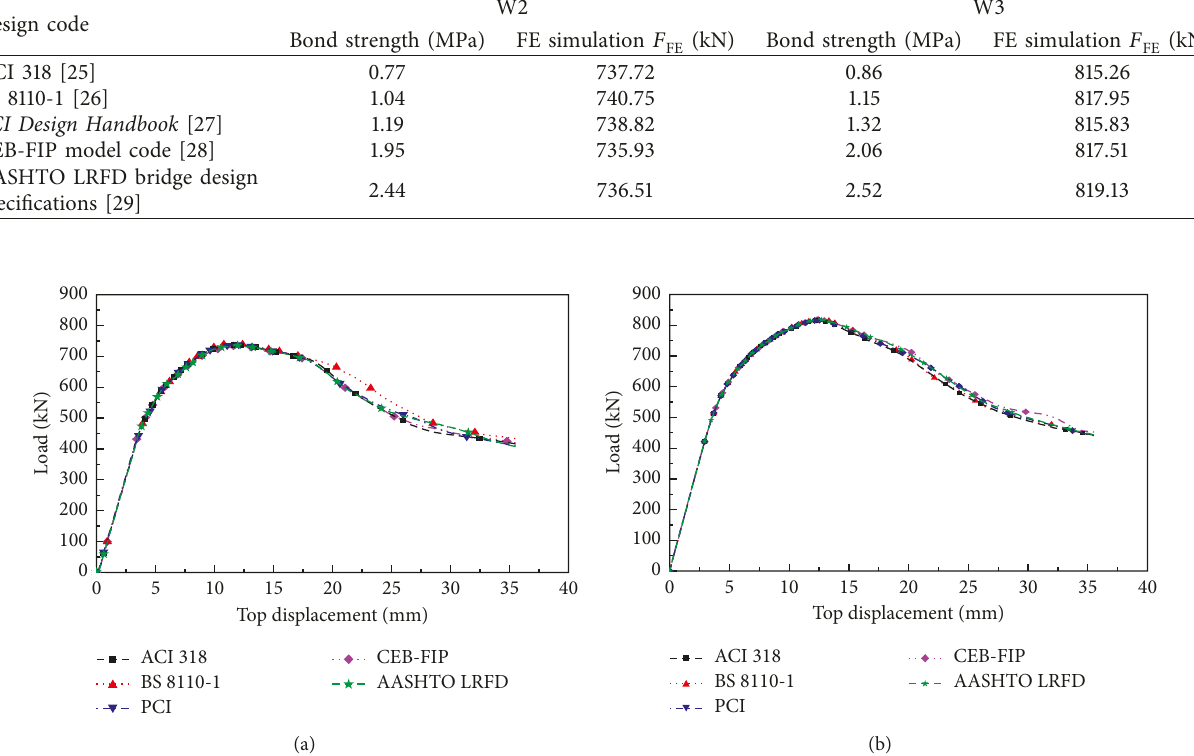
Figure 24: Comparison of load-displacement curves under 0.5 axial compression ratio: (a) W2 and (b)